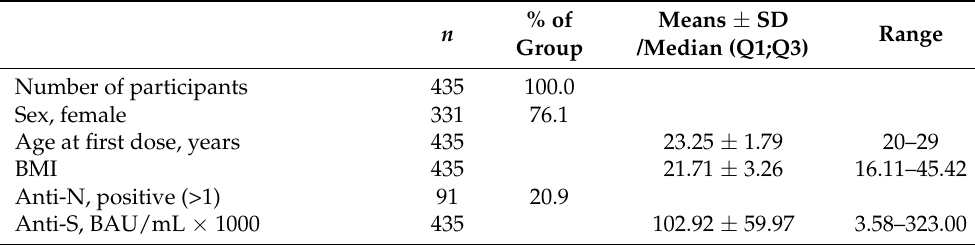
Table 4. Characteristics of the circadian